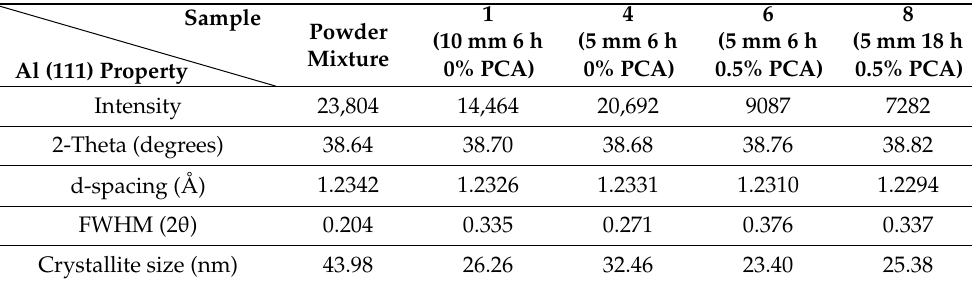
Table 3. XRD results of mechanically alloyed